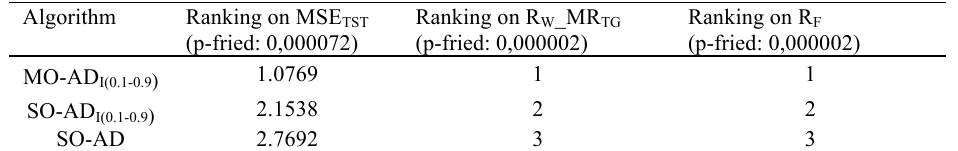
Table B.2 Rankings obtained through Friedman’s test for different values of thresholds on MSE TST , R W _AvR TG and #R F